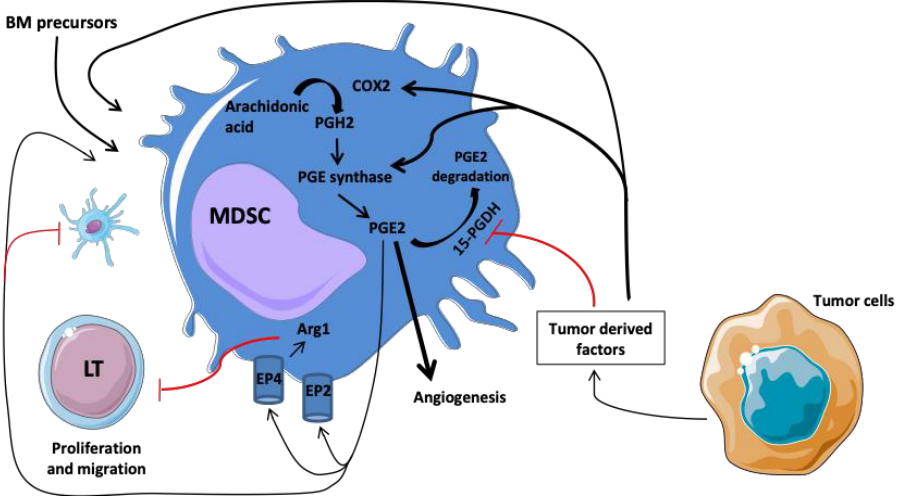
Figure 1. Involvement of COX2/PGE2 pathway in the regulation and differentiation of MDSC. The tumor microenvironment promotes the production of COX2 promoting the synthesis of PGE2. EP4 receptor expressed on MDSC can bind PGE2 and induced arginase-1 (Arg1) production. Arg1 accelerates l-arginine consumption, resulting in suppression of T-cell proliferation. Abbreviations: Arg1, arginase; BM, bone marrow; and PGH2, prostaglandin